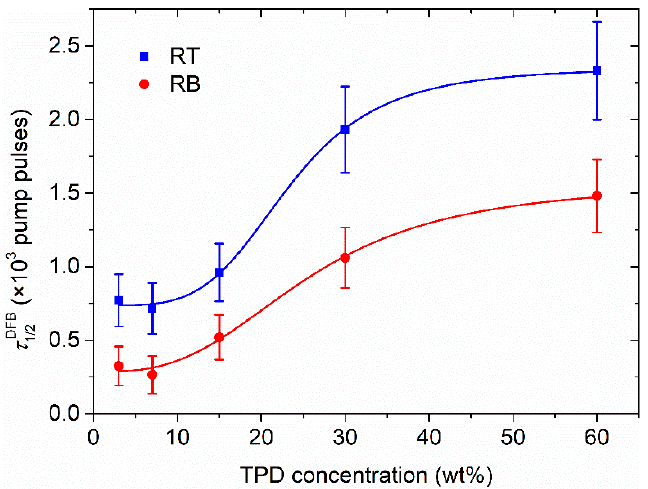
Figure 10. Photostability of DFB lasers based on TPD for RB and RT configurations.